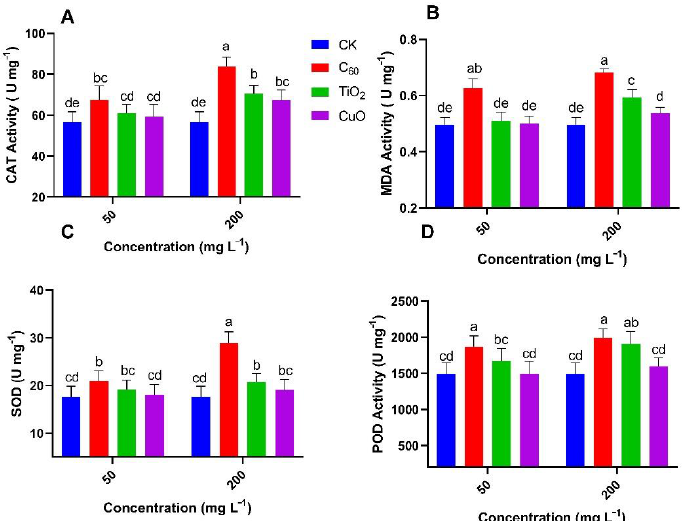
Figure 8. Effect of NMs treatment on the mean content (n = 3) of ( A ) catalase, ( B ) malondialdehyde, ( C ) superoxide dismutase and ( D ) peroxidase enzymes in sweet potato (J26) exposed to soft rot disease. Different small letters represent significant difference according to Duncan’s multiple range test ( p < 0.05. n = 3).